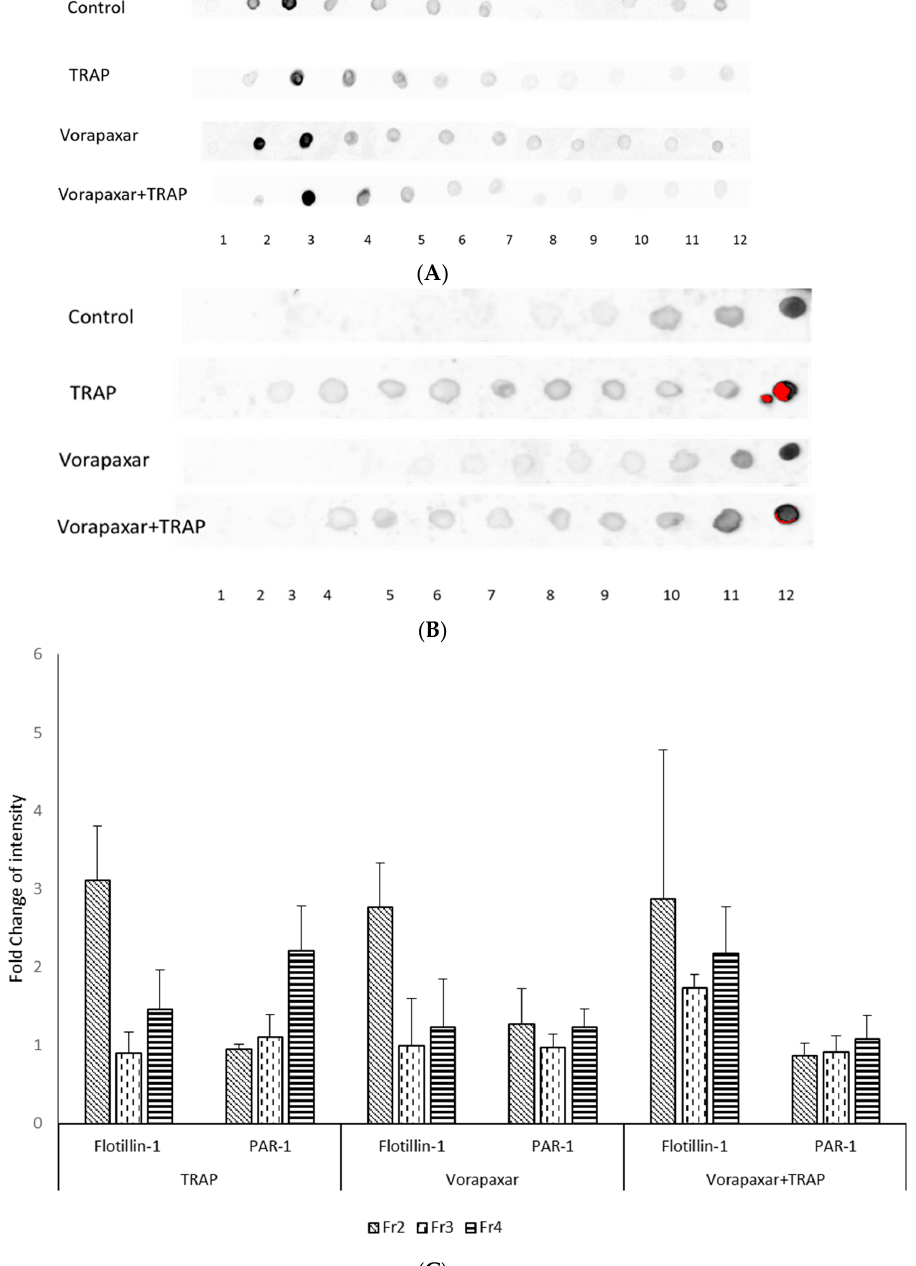
Figure 3. Assessment of colocalization of PAR1 and cholesterol-rich microdomains by a biochemical approach. ( A ) Flotillin-1, a marker of cholesterol–rich microdomains, was mainly detected in fractions 2–4 in all experimental groups; ( B ) PAR1 was mainly present in fractions 10–12, which did not contain cholesterol-rich microdomains; ( C ) Quantitative dot blot of flotillin-1 and PAR1 in experimental